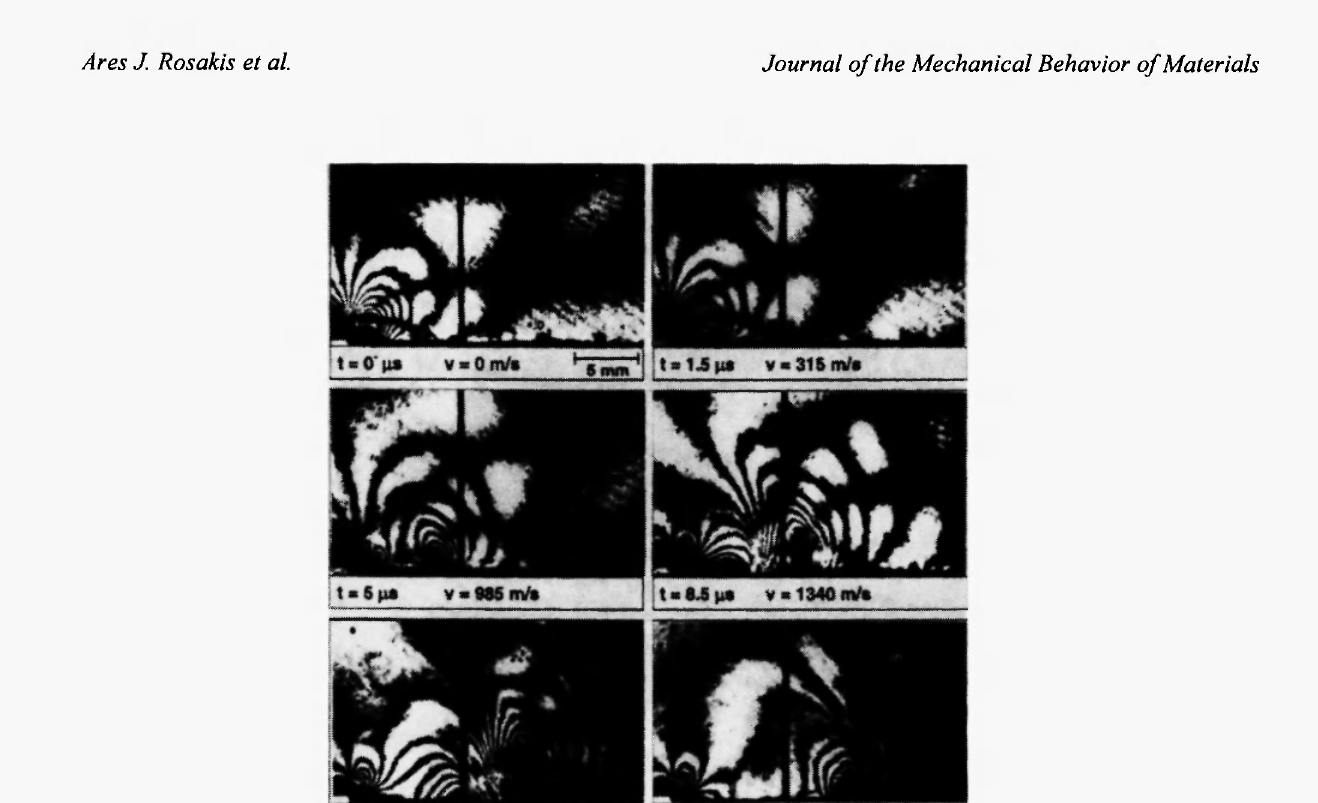
Figure 4: CGS fringes obtained for dynamic crack growth along a PMMA/steel bimaterial interface subjected to impact loading.